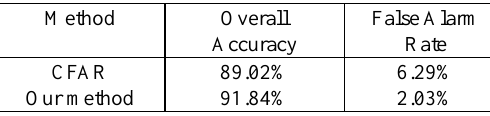
Table 1. Performance Evaluation of change